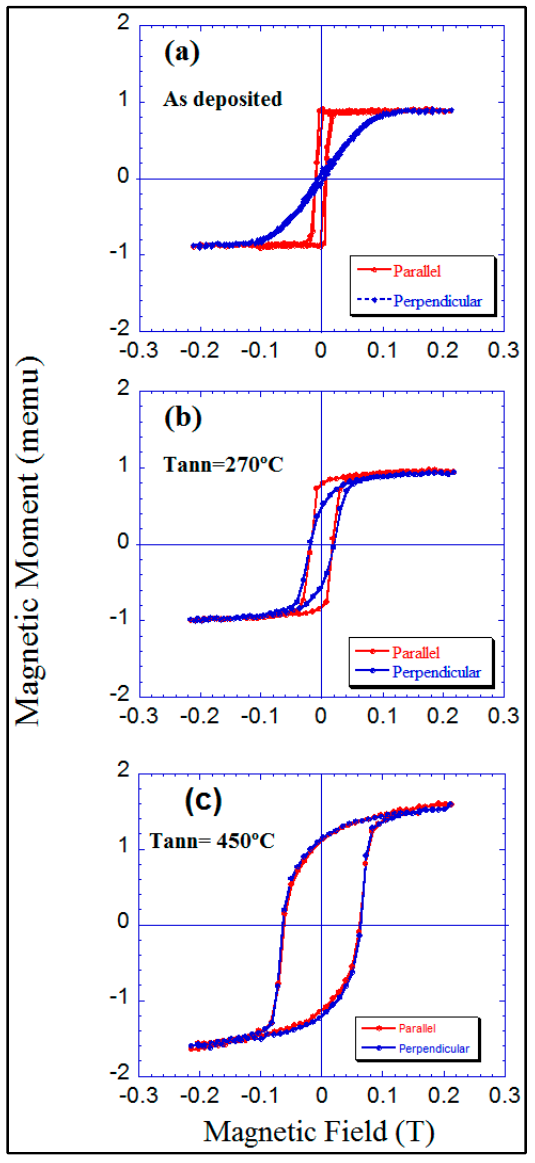
Figure 6. Hysteresis loops measured at room temperature parallel and perpendicular to the direction of the nano-sheets of the Co samples: ( a ) as-deposited sample; ( b ) 270 °C annealed; ( c ) 450 °C annealed.